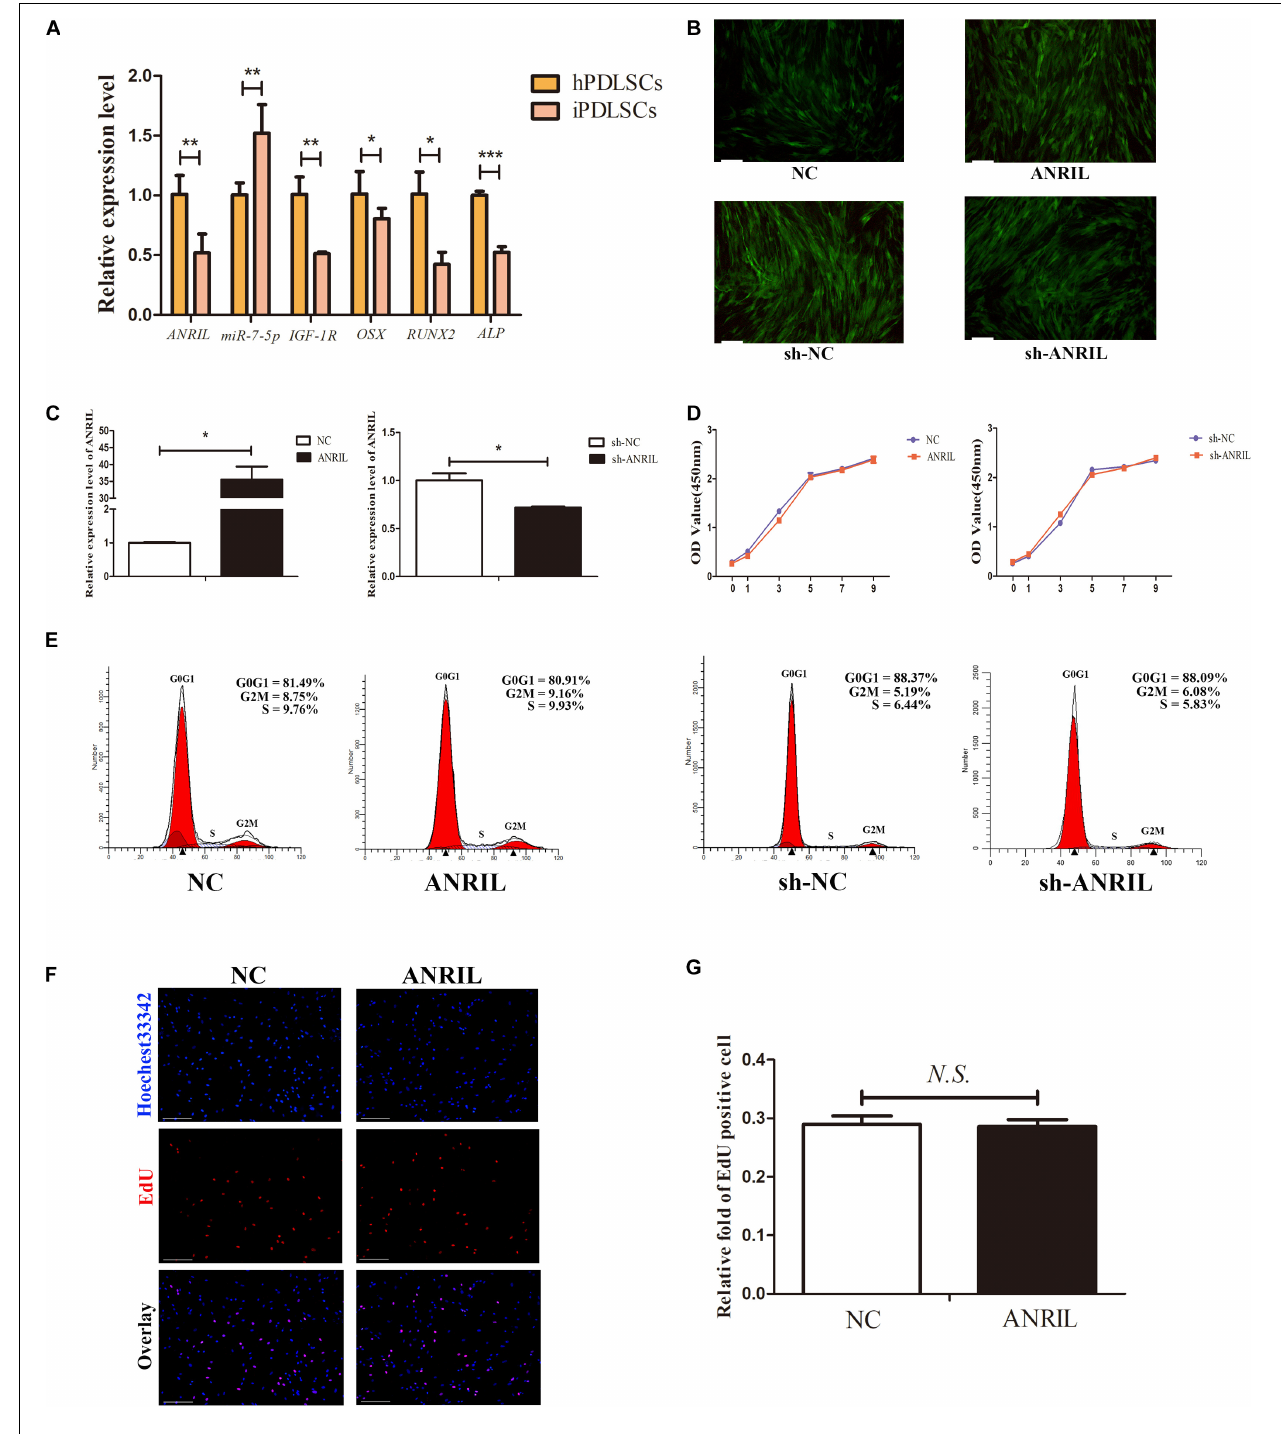
FIGURE 1 | (A) The expression levels of long non-coding RNA ( lncRNA) antisense non-coding RNA INK4 locus (ANRIL),miR-7-5p, insulin-like growth factor-1 receptor (IGF-1R), alkaline phosphatase (ALP), OSX, and RUNX2 were determined by quantitative real-time polymerase chain reaction (qRT-PCR) in healthy periodontal ligament stem cells (hPDLSCs) and inflamed periodontal ligament stem cells (iPDLSCs). (B) Fluorescent photomicrographs showed lentivirus transfection in NC, ANRIL, sh-NC, sh-ANRIL groups. (Scale bar = 100 µ m). (C) The transfection efficacy of ANRIL was measured by qRT-PCR in ANRIL group and sh-ANRIL group. GAPDH was used for normalization. (D) Proliferative ability of iPDLSCs was detected by Cell Counting Kit-8 (CCK-8) assay. (E–G) Flow cytometry and EdU assay demonstrated that ANRIL had no significant difference in cell proliferation of iPDLSCs on day 7 (Scale Bar = 100 µ m; N.S., P > 0.05) (* P < 0.05, ** P < 0.01, *** P <